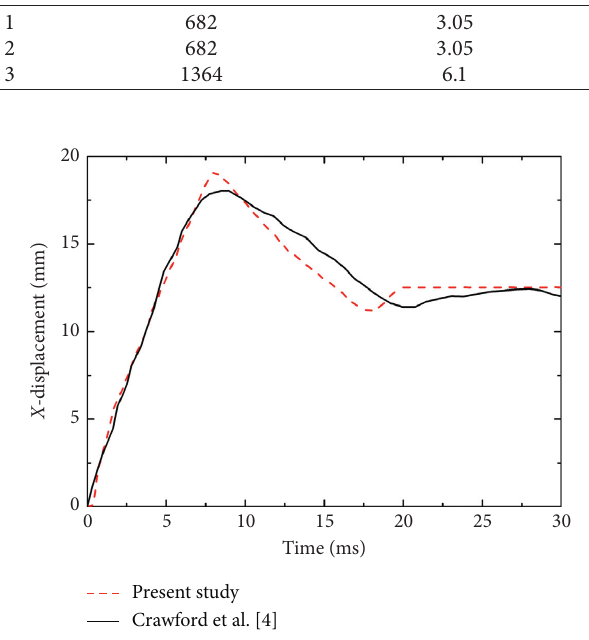
Figure 10: Displacement history curve at midspan of the column in Case